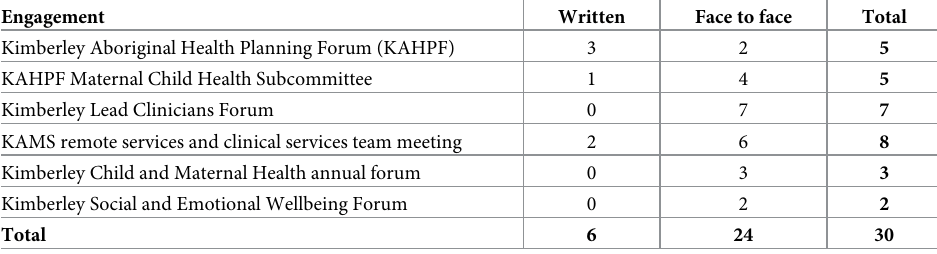
Table 4. Occasion and type of Kimberley stakeholder